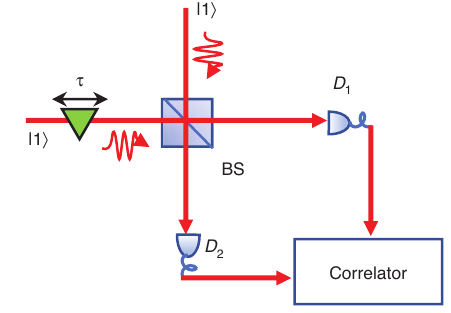
Figure 3: Schematic representation of the HOM two-photon interference experiment.